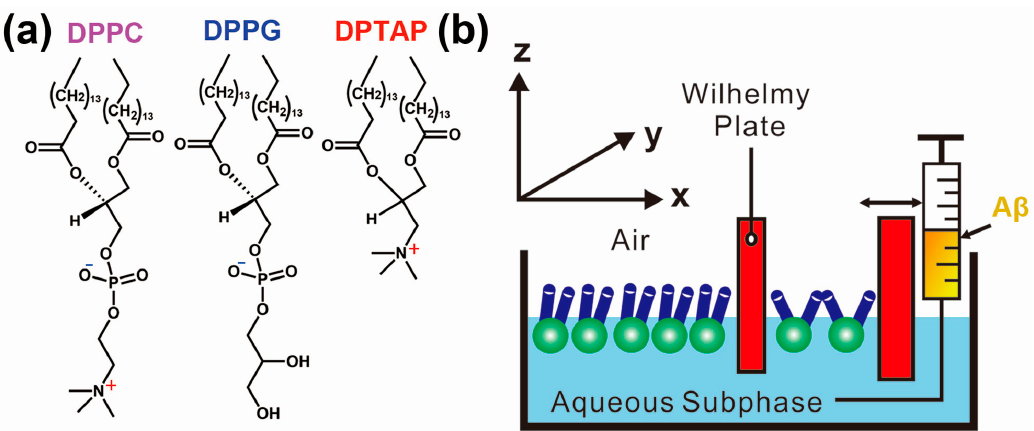
Figure 4. ( a ) Structures of the lipids used. The lipids have identical saturated 16-carbon acyl chains but differ in their head group architecture and charge; ( b ) Schematic of a Langmuir trough containing a lipid monolayer. The movable barrier controls the lipid density of the film and the Wilhelmy plate measures the surface pressure. A β 40 solution (250 nM) was injected into the aqueous subphase of the trough using an L -shaped syringe underneath the barrier [84]. ( a , b ) Adapted with permission. Copyright 2008, WILEY-LISS.